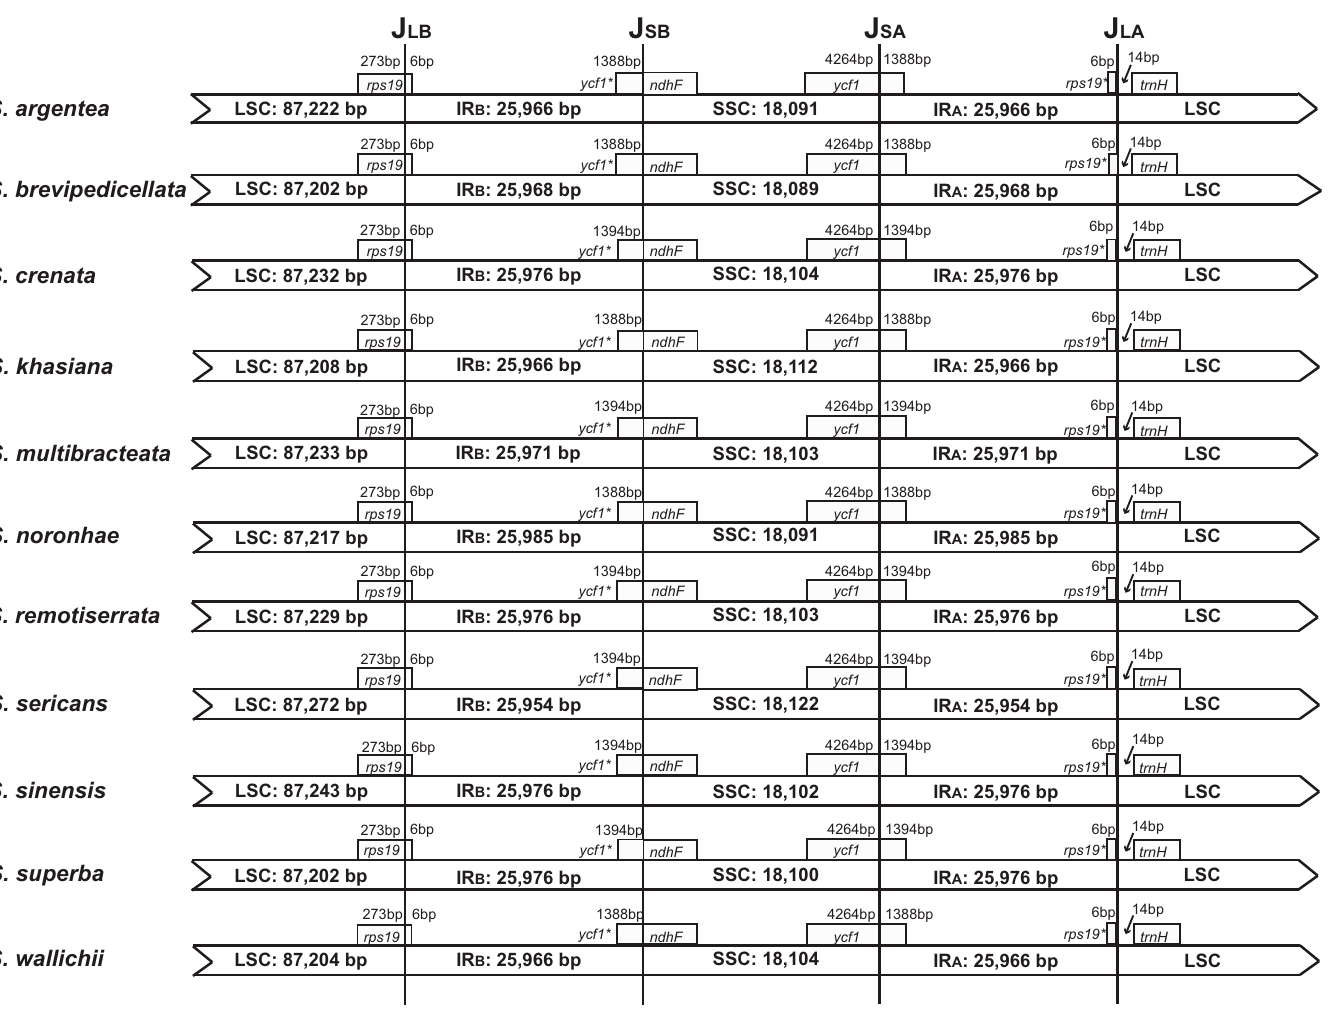
Fig 2. Comparisons of the border regions among the chloroplast genomes of 11 Schima species. ycf1 * ( ycf1 _like)and rps19 * ( rps19 _like) represent the incompleteduplicationof the gene within the IR